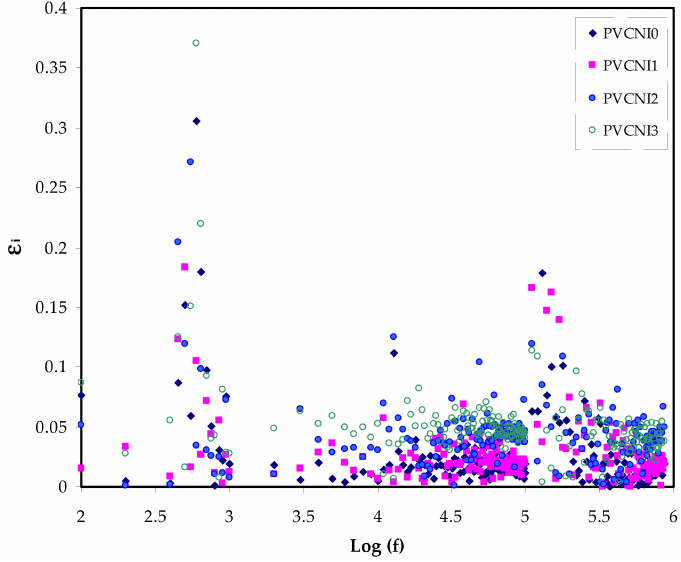
Figure 6. ε i versus log ( f ) for all the electrolyte samples.